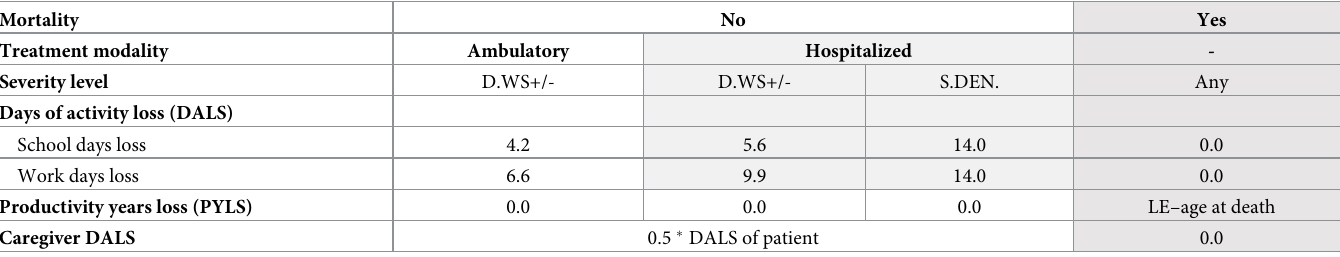
Table 1. Estimation of days of activity loss and productivity years loss depending on the level of disease and treatment modality.